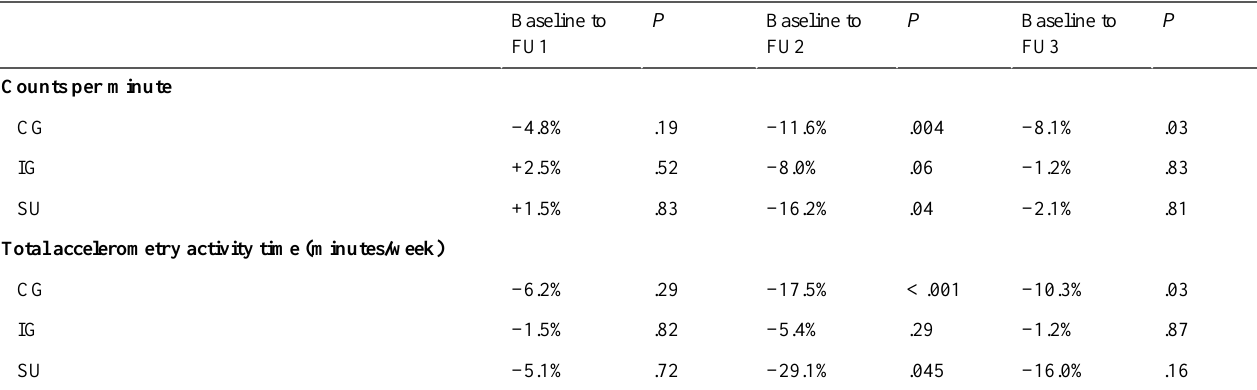
Table 4. Percent changes in objective physical activity between baseline and each follow-up according to group a